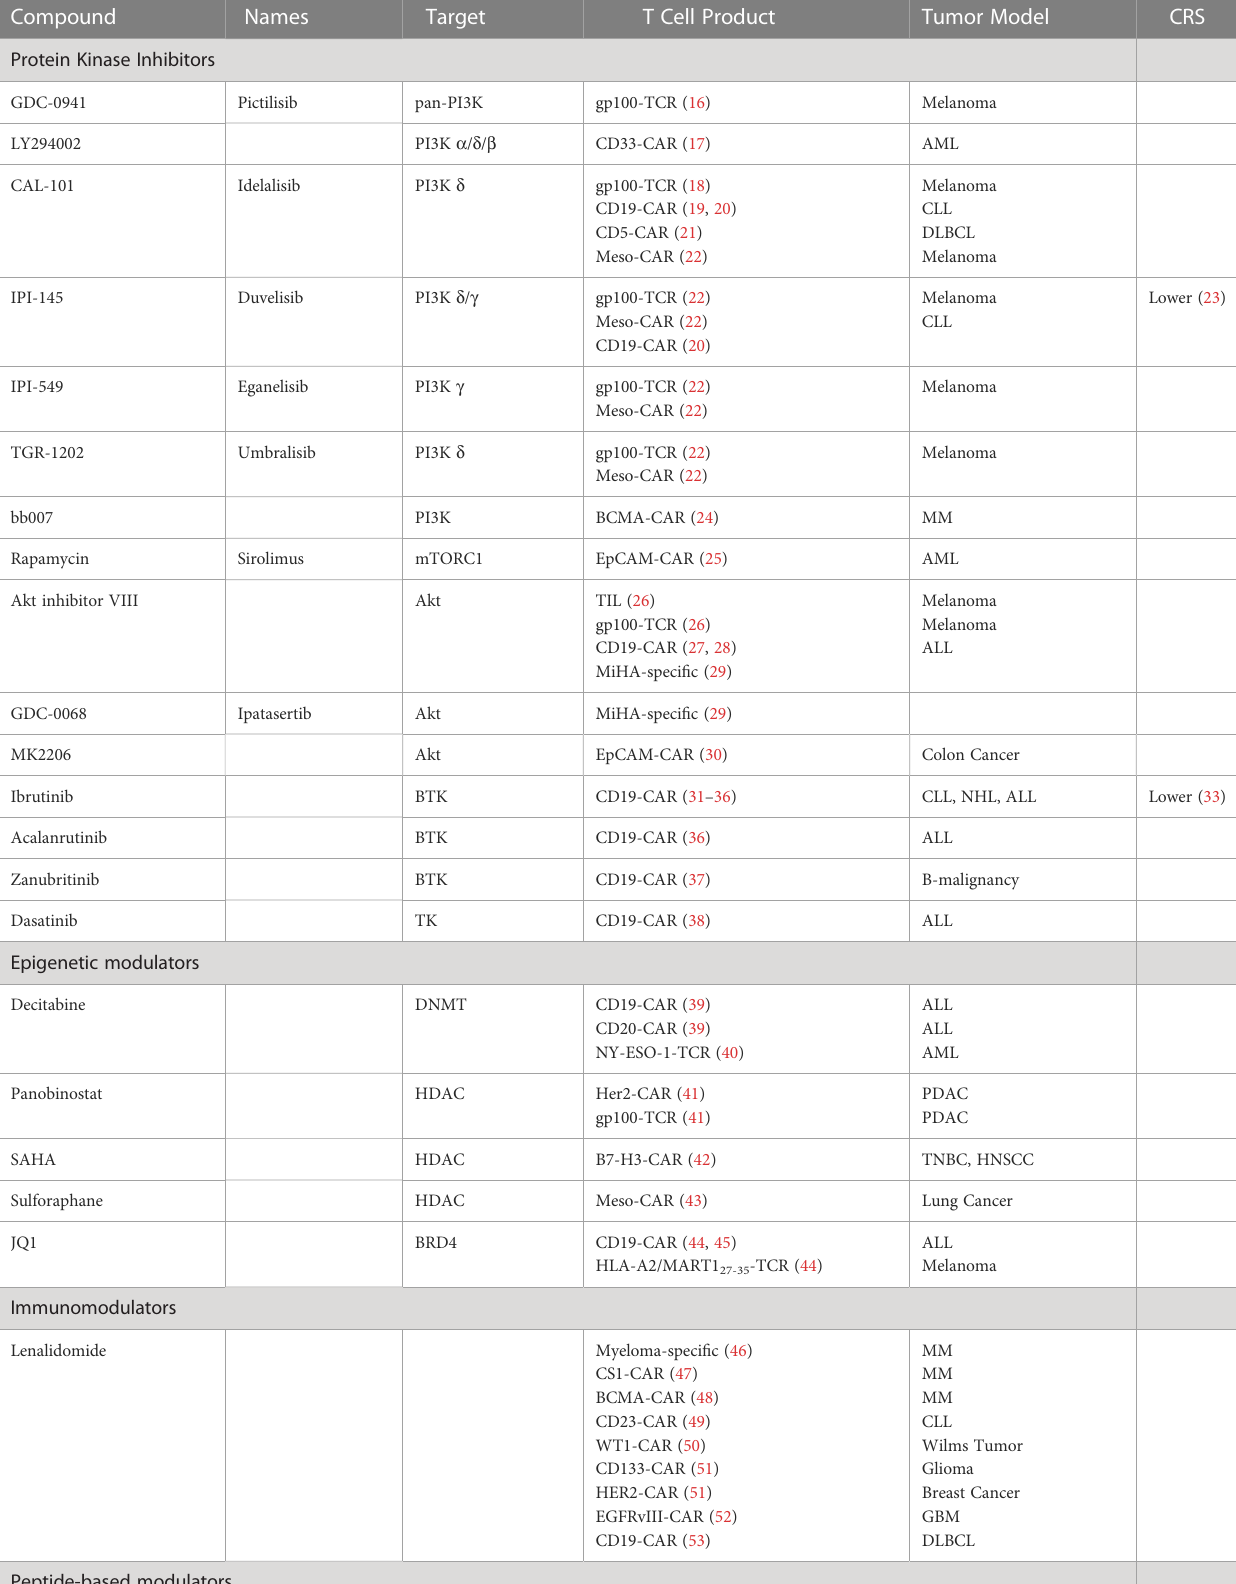
TABLE 1 Summary of small-molecule drugs enhancing adoptive T cells ex vivo